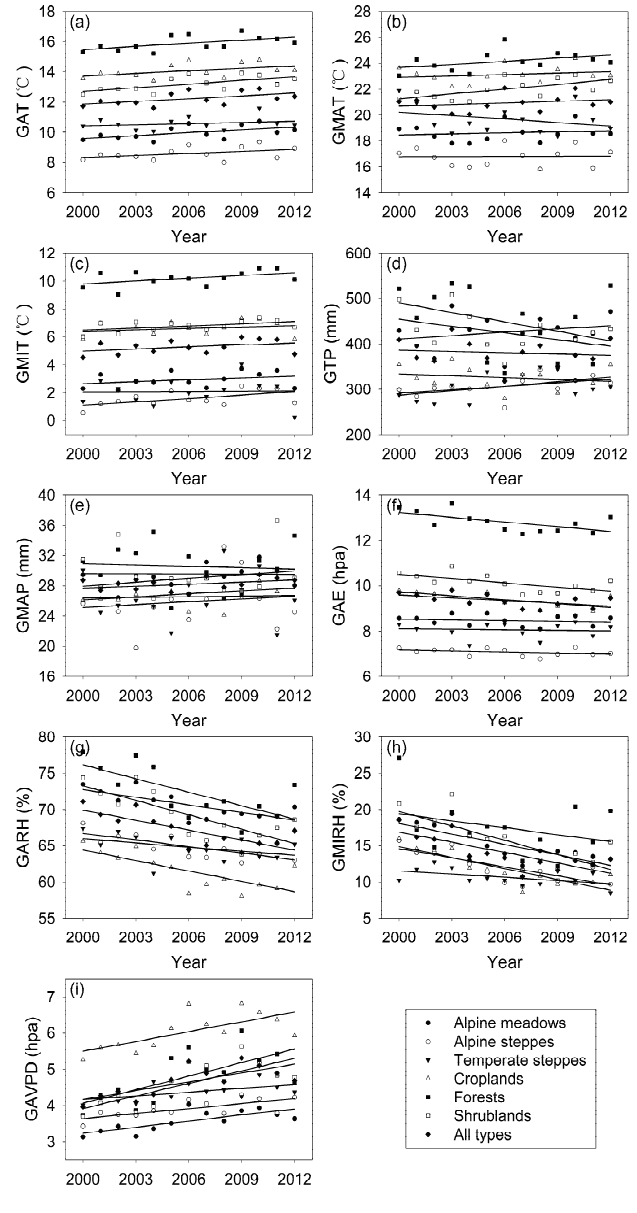
Figure 2. Linear trends for: ( a ) the growing season average temperature (GAT); ( b ) maximum temperature (GMAT); ( c ) minimum temperature (GMIT); ( d ) total precipitation (GTP); ( e ) maximum precipitation (GMAP); ( f ) average vapor pressure (GAE); ( g ) average relative humidity (GARH); ( h ) minimum relative humidity (GMIRH); and ( i ) average vapor pressure deficit (GAVPD); from 2000 to 2012 from 81 meteorological stations on the Tibetan